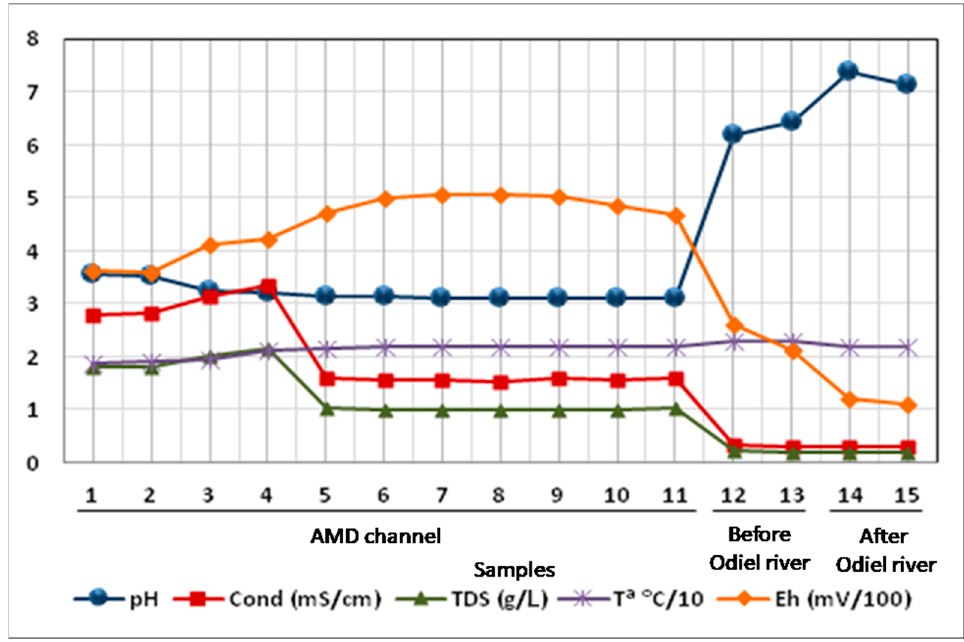
Figure 4. Spatial evolution of the parameters analysed in situ.